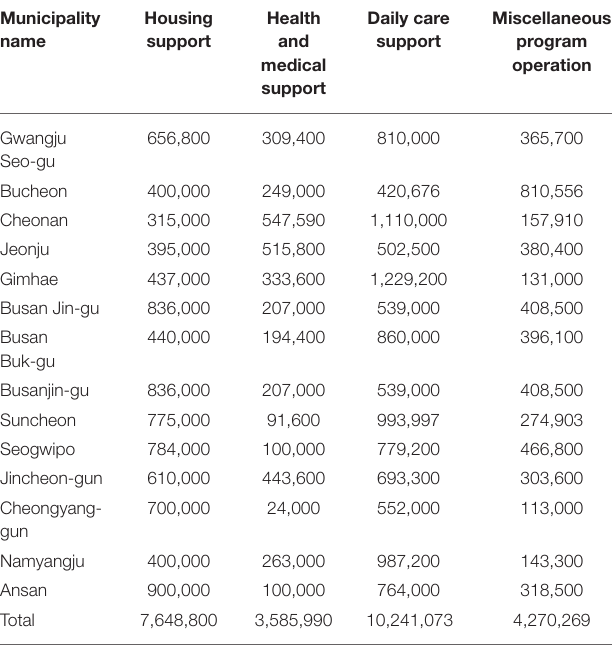
TABLE 4 | Budget status by program type and region.